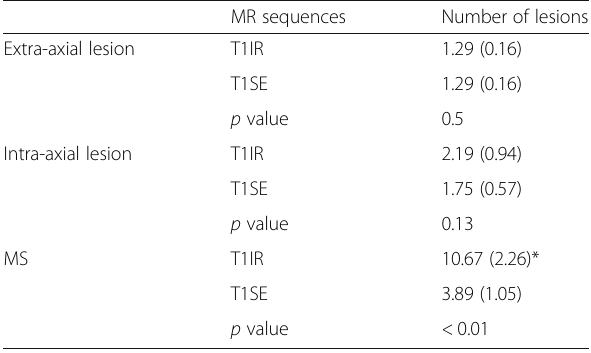
Table 4 Difference between T1IR and T1SE based on number of lesions MR sequences Number of lesions Extra-axial